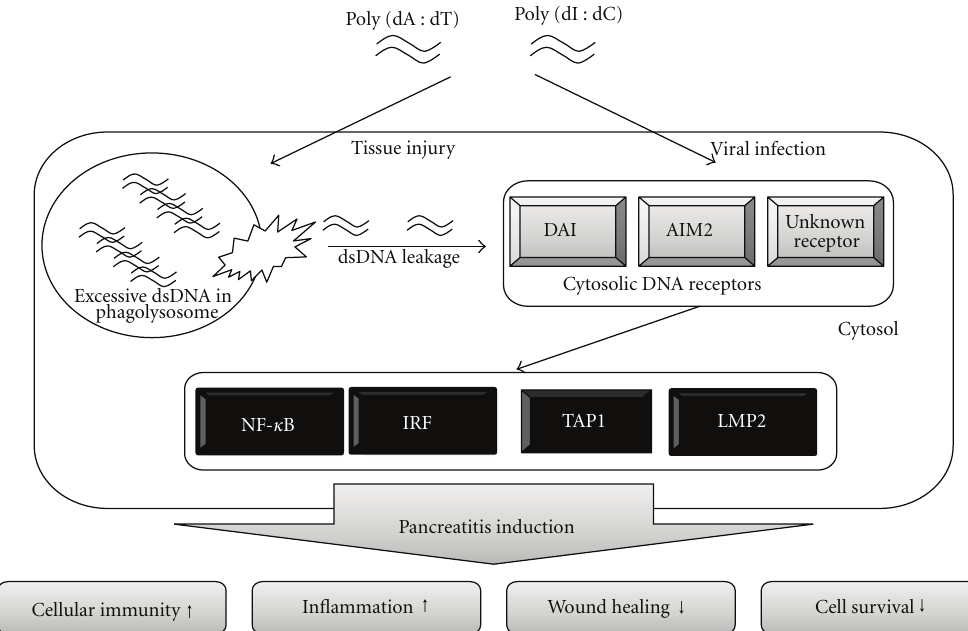
Figure 6: Model for mechanisms triggered by intracellular double-stranded DNA (dsDNA) in PSCs. The scheme depicts the induction of the innate immune response by dsDNA reflecting the onset and exacerbation of pancreatitis under sterile an nonsterile conditions.